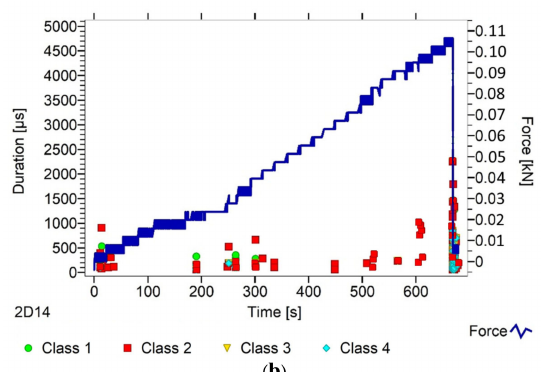
Figure 7. AE signal graphs for the mock BC sample: ( a ) signal strength distribution in time; ( b ) signal duration distribution in time, with plotted force increment curve.